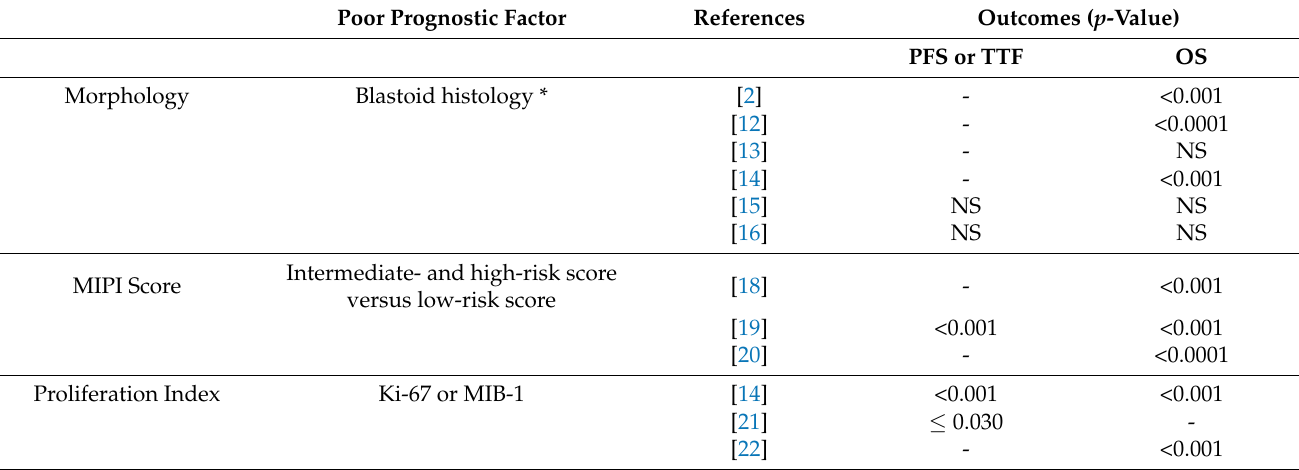
Table 1. Prognostic Factors Determined at Initial